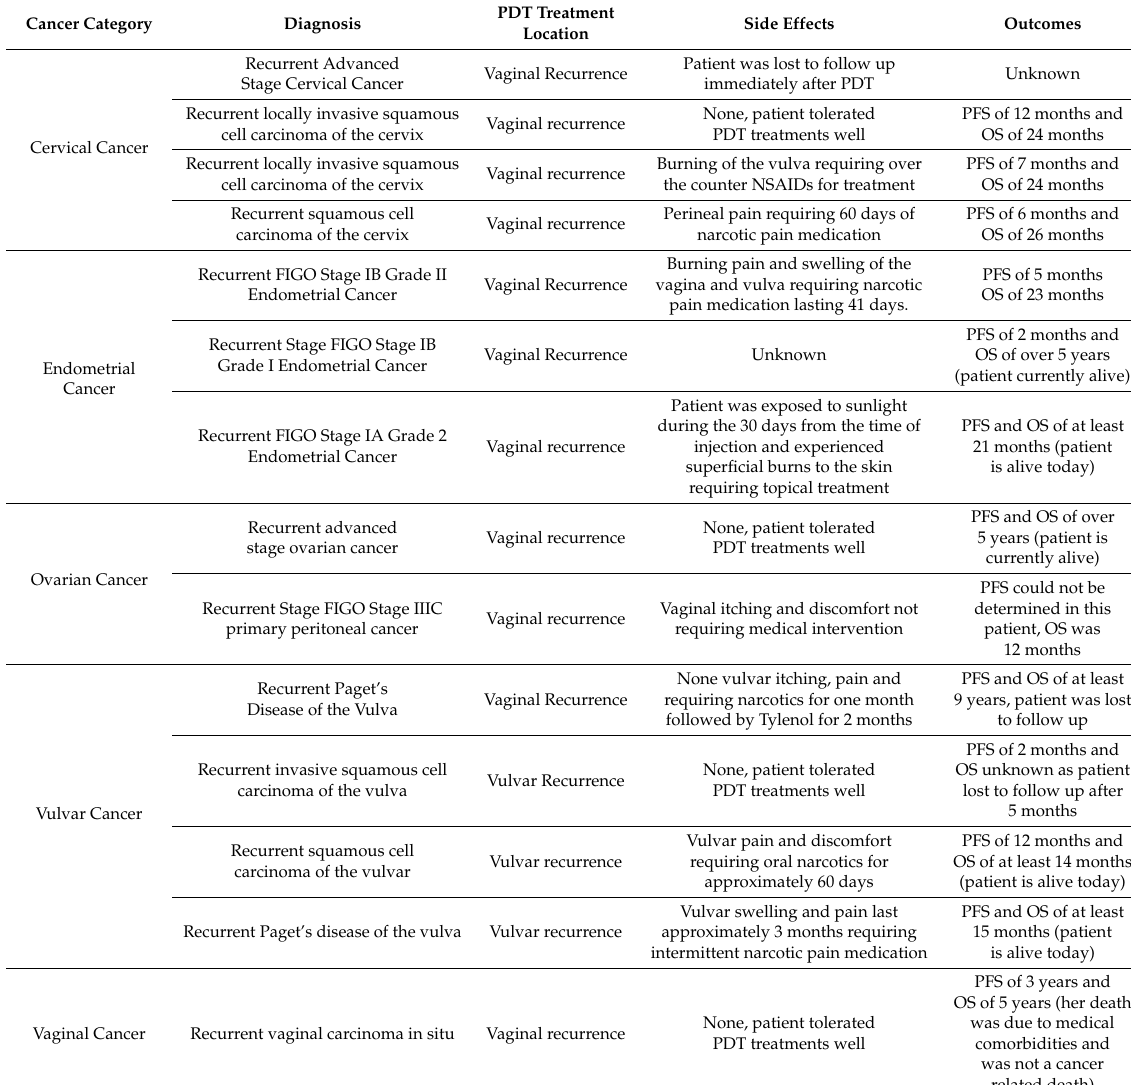
Table 1. Patients characteristics and outcomes from 2002 to